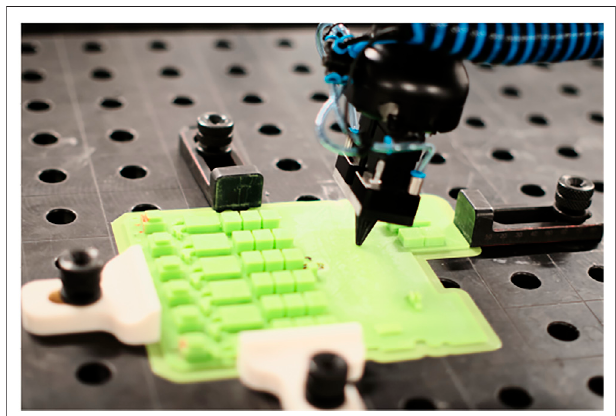
FIGURE 6 | Robot executing the taught gluing-like task on our benchmark system. Notice the 3D-printed mock-up PCB (in green) and the 3D-printed mock-up gluing tip in a conical shape attached to the robot end-